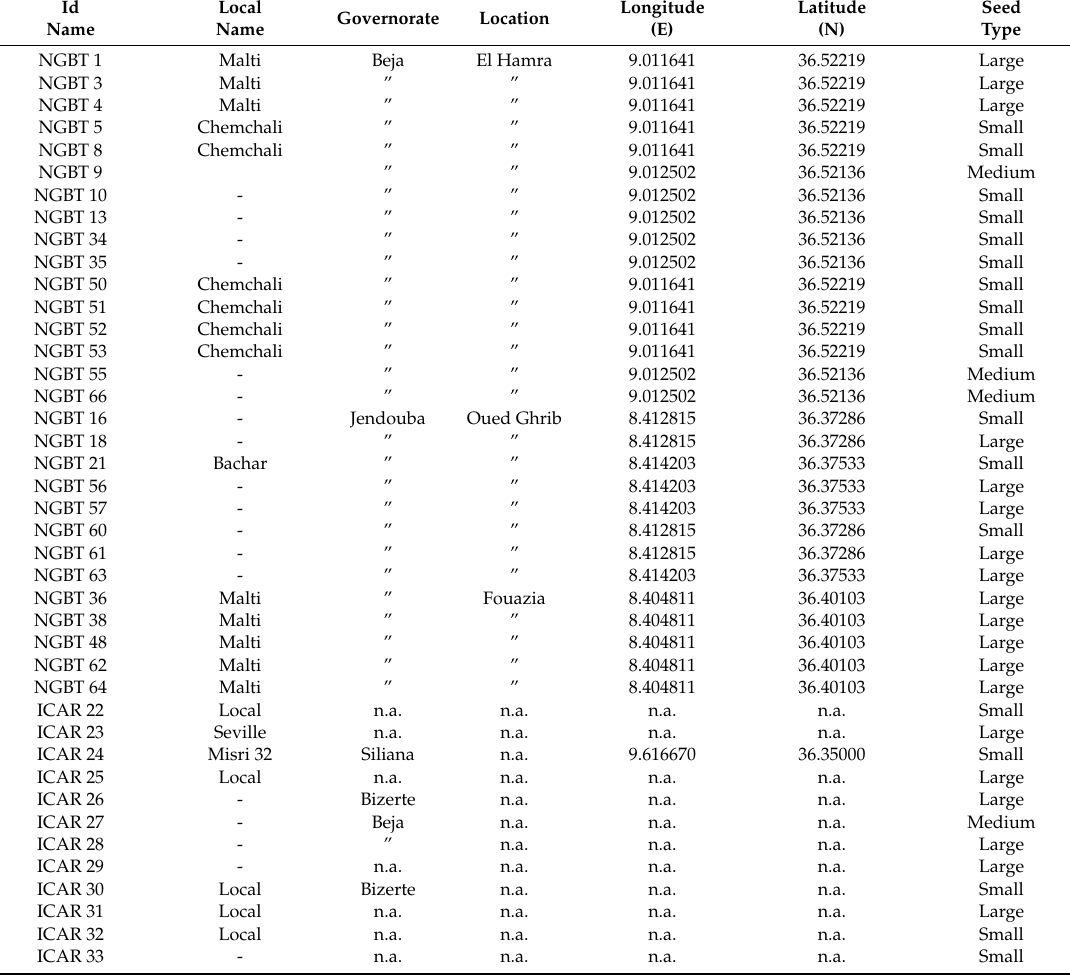
Table 1. List of faba bean samples included in the